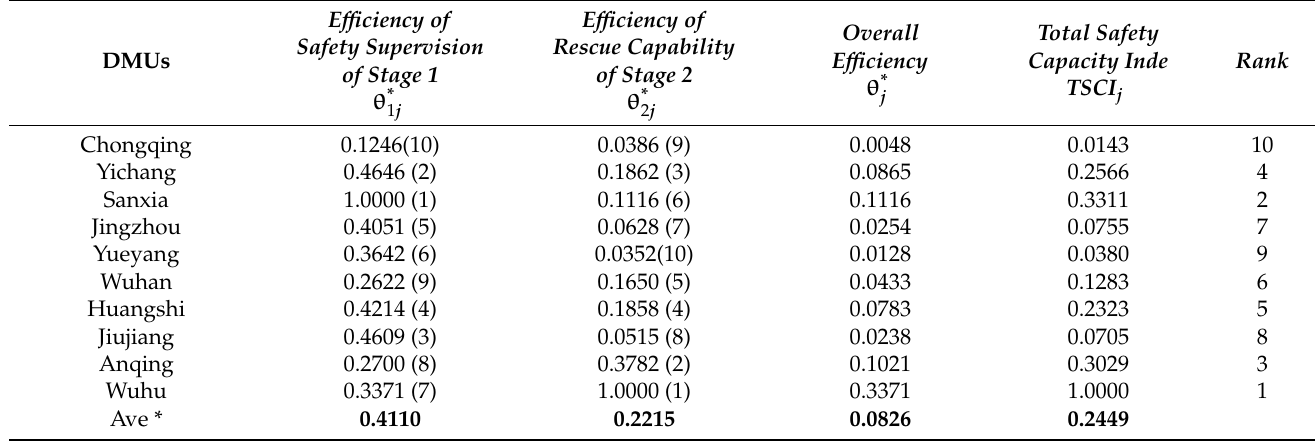
Table 4. Research data and evaluation results in this